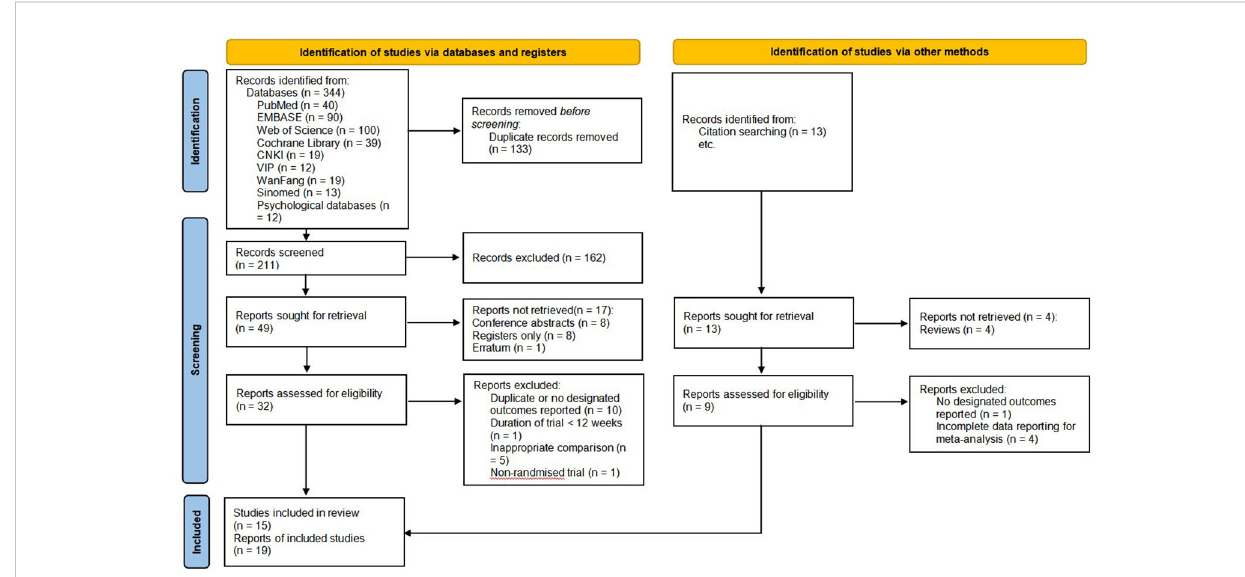
FIGURE 1 Flow diagram of identi fi cation, screening, and systematic review of Tai Chi Chuan training on the QoL and psychological well-being in women patients with breast cancer